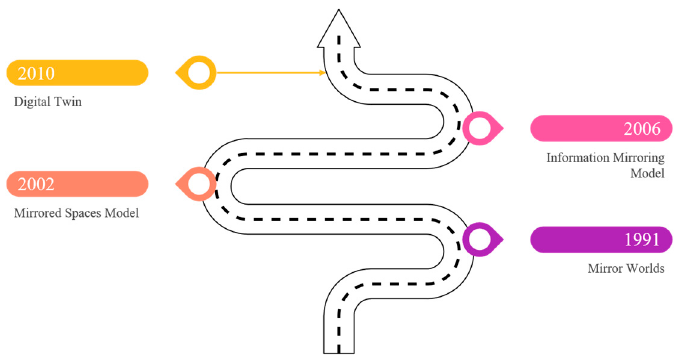
Figure 4. Digital twin evolution timeline.